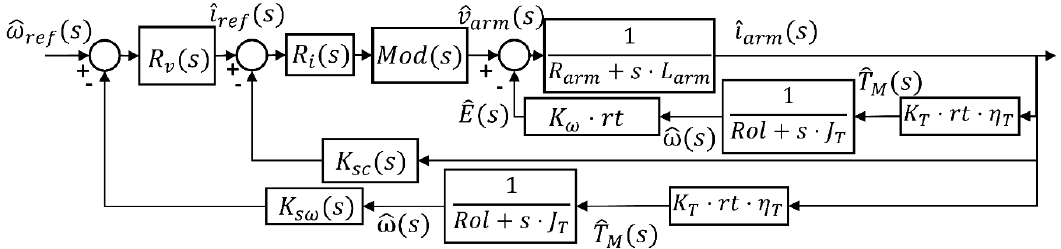
Figure 7. Block diagram of the small-signal model of DC motor and vehicle together with the control loops.